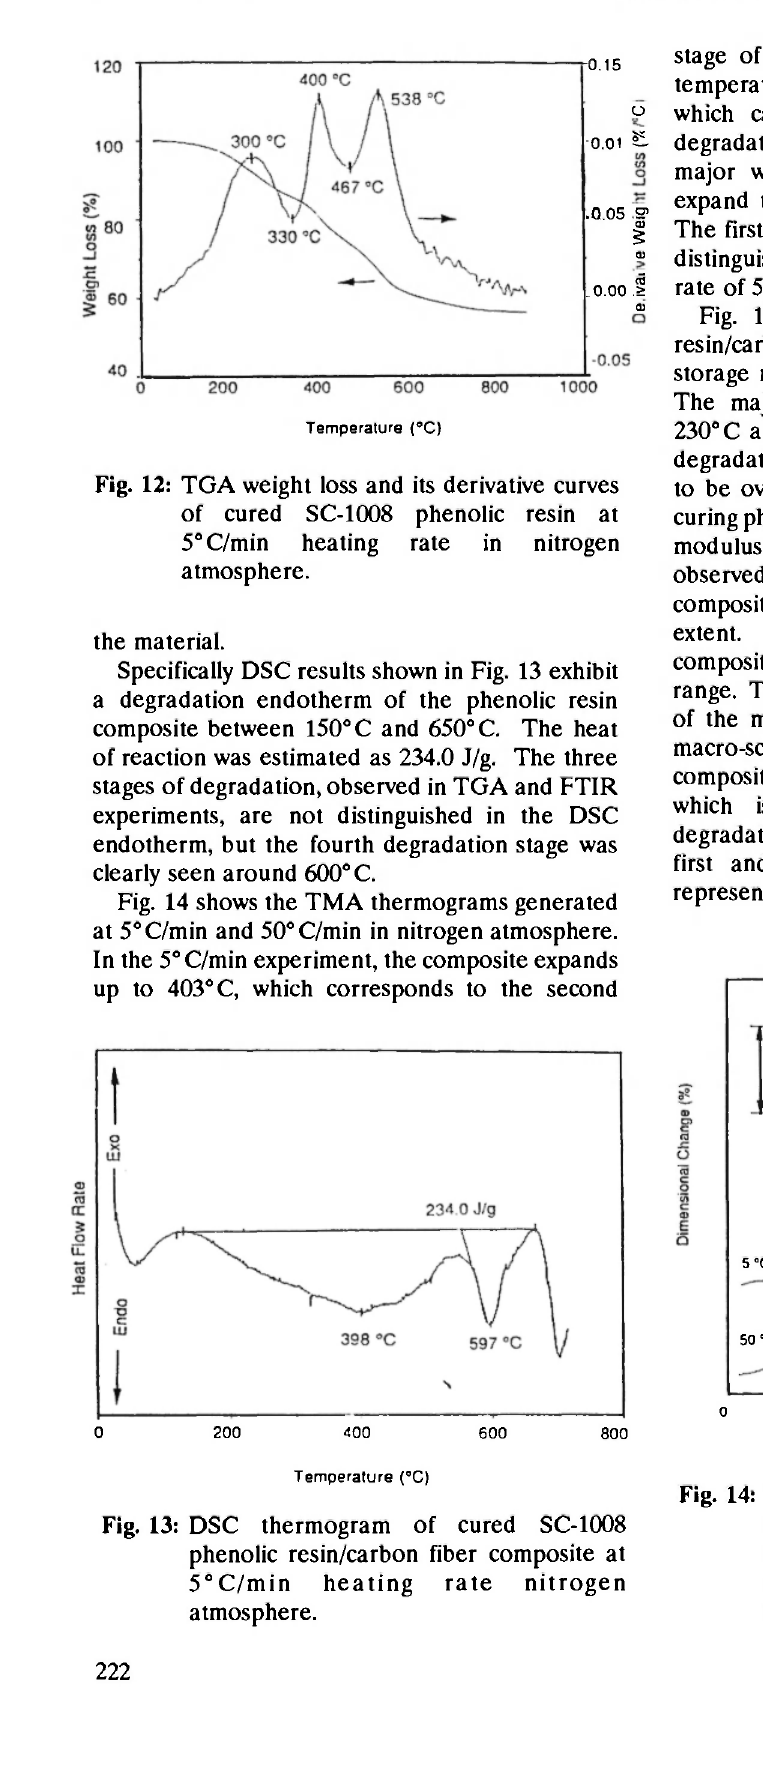
Fig. 13: DSC thermogram of cured SC-1008 phenolic resin/carbon fiber composite at 5°C/min heating rate nitrogen atmosphere.